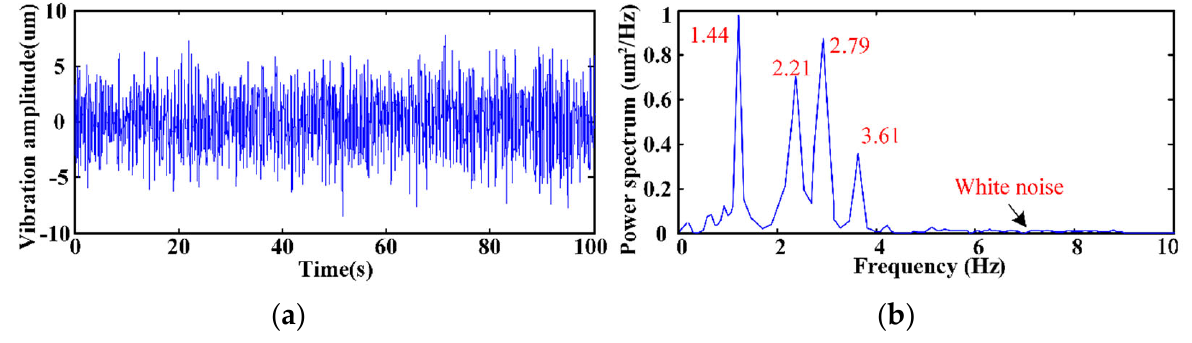
Figure 4. Time history signals and power spectra of B2 measuring point under condition 2. ( a ) Time history signals; ( b ) Normalized power spectra.